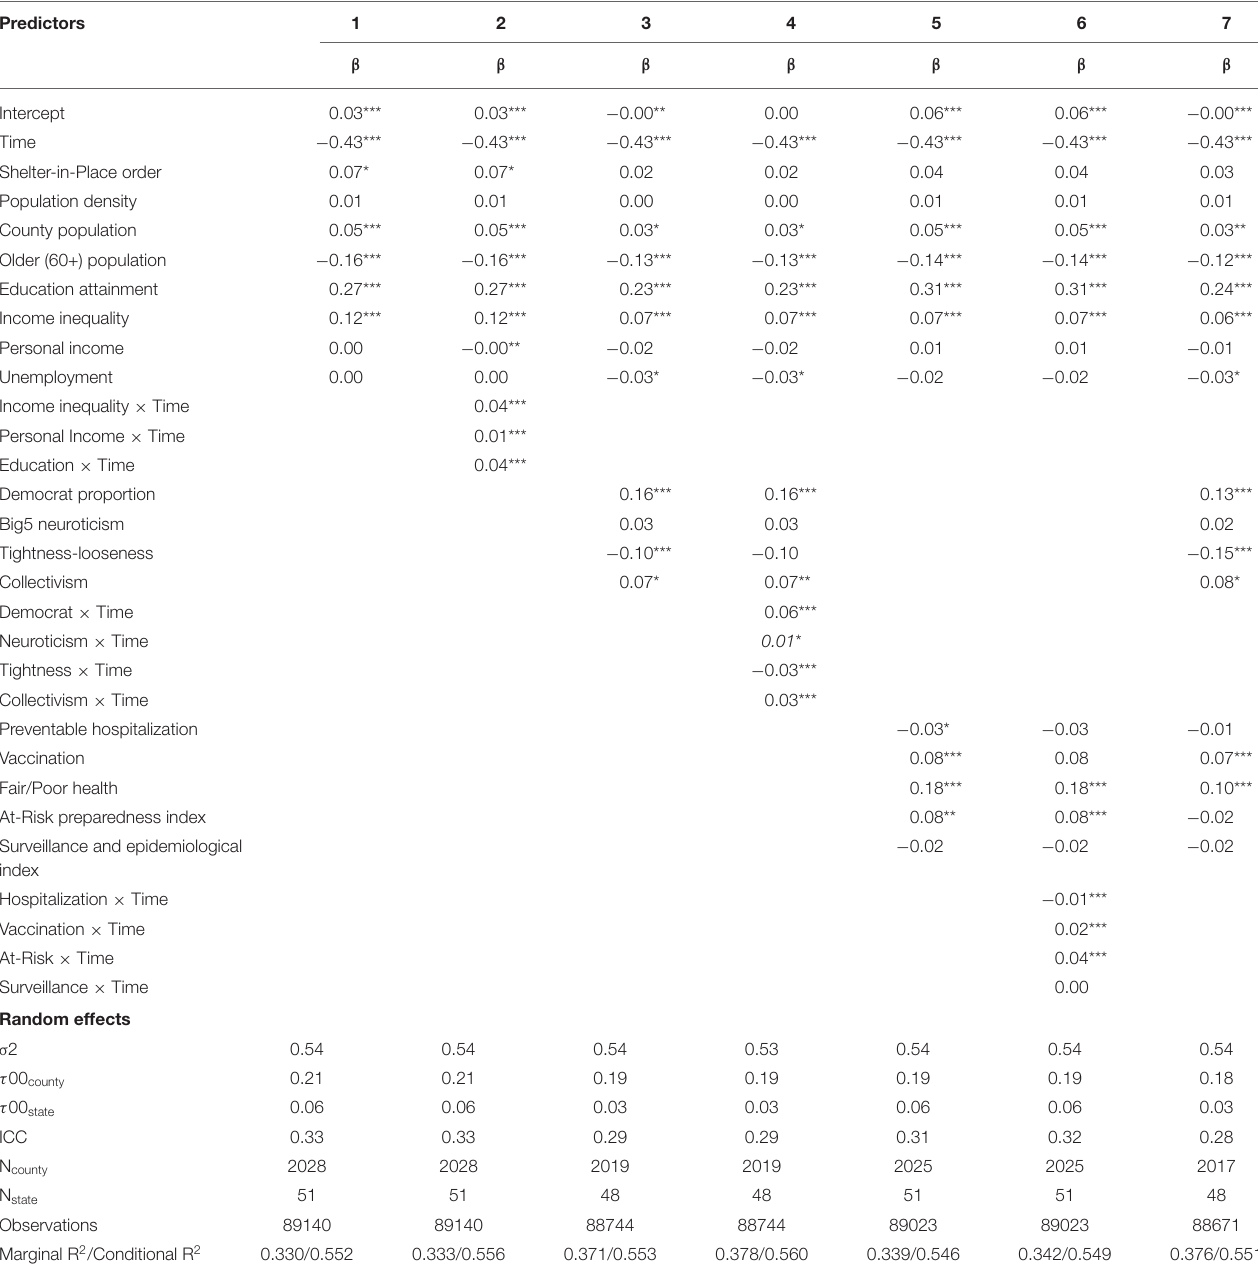
TABLE 5 | Reduction in essential visitation mobility (From April 13 to May 24,